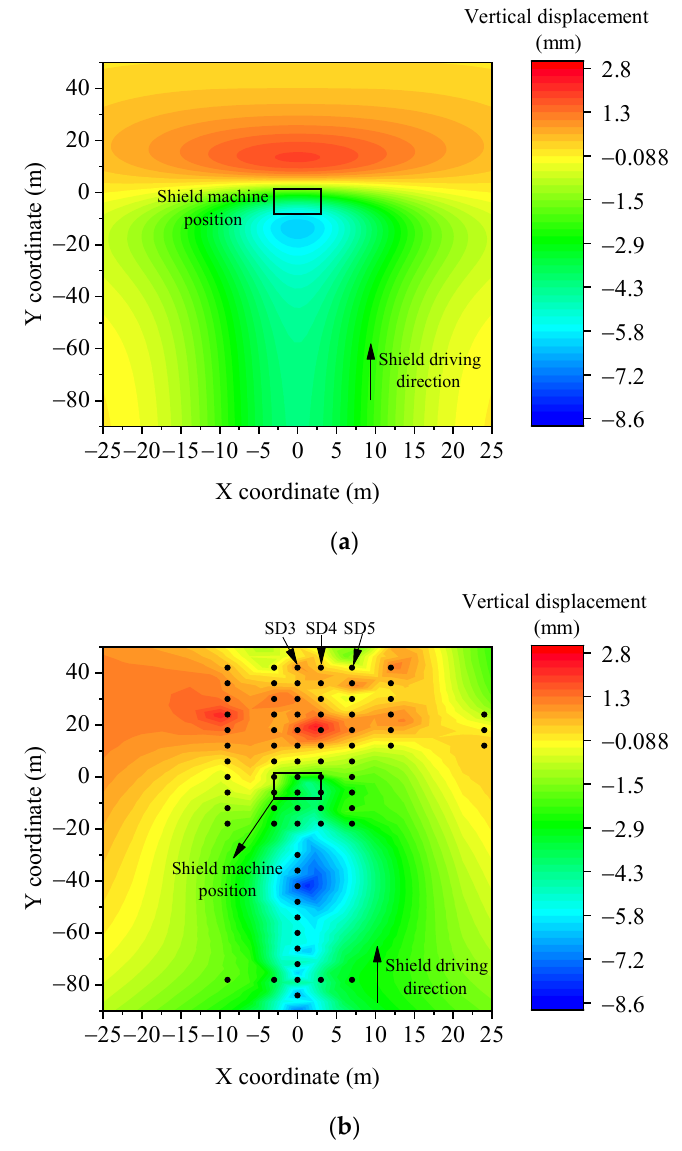
Figure 13. Comparison of predicted and monitored ground surface displacement in case A. ( a ) predicted displacement; ( b ) monitored displacement.